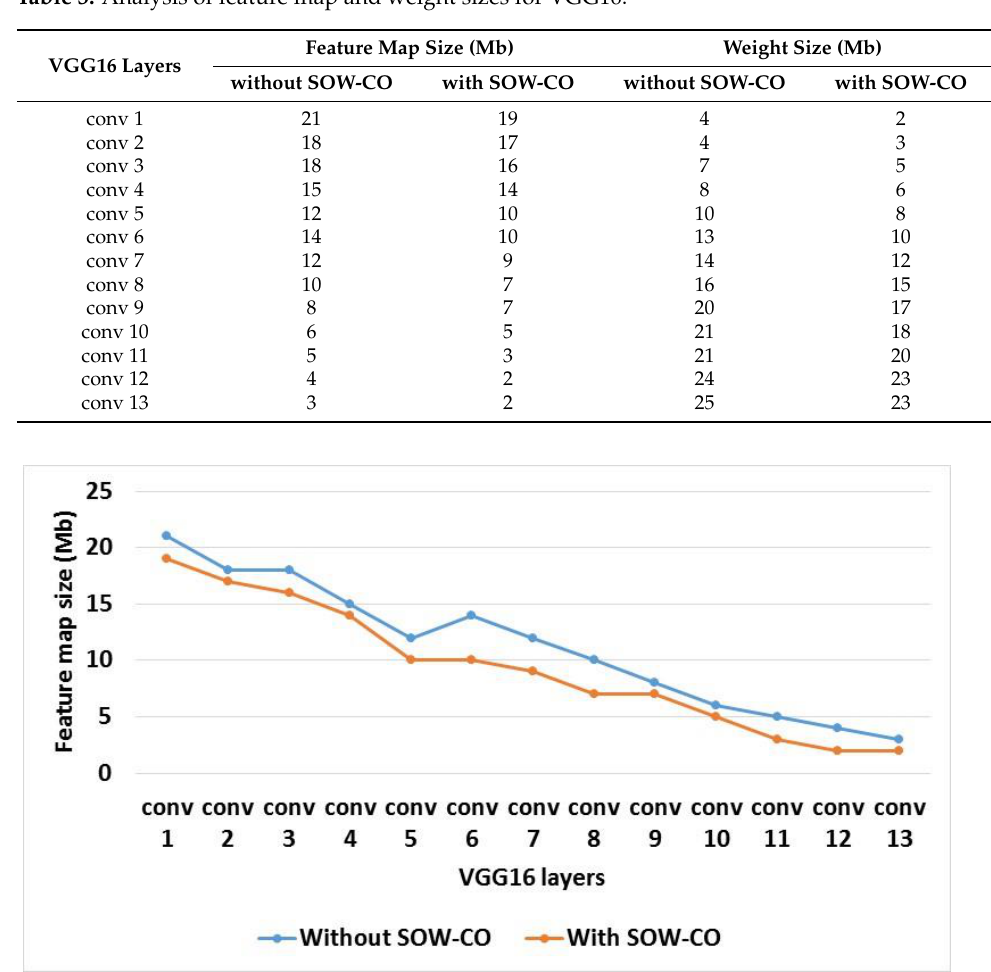
Figure 11. Graphical illustration of feature map size for VGG16.